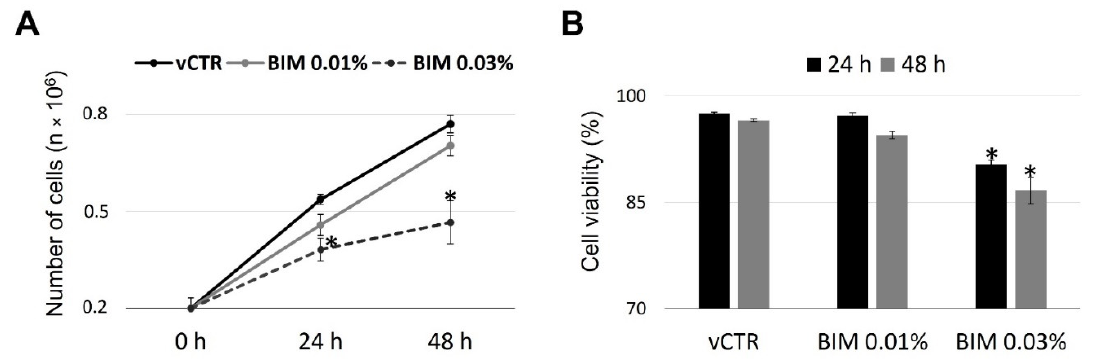
Figure 1. Bimatoprost (BIM) 0.01% does not induce changes in human conjunctival epithelial (HCE) cells proliferation and viability. Cell growth ( A ) and viability ( B ) rate in control (vCTR) and treated HCE cells incubated for 24 and 48 h with BIM 0.01% and 0.03%. BIM 0.03% induces a significant decrease in cell growth and viability at 24 and 48 h. Results are the media of three independent experiments ± SE; one-way ANOVA (Dunnett’s method); * p < 0.05 compared with